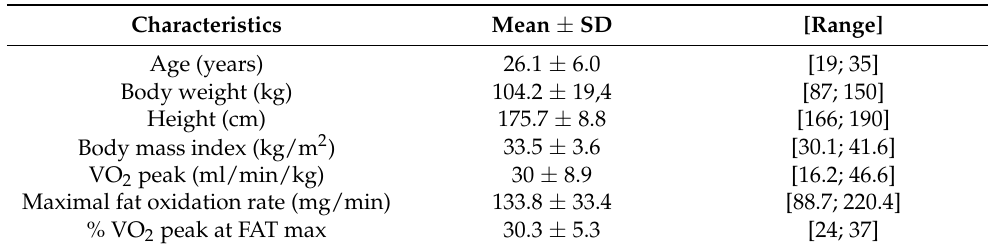
Table 1. Anthropometric data and physiological values measured during the exhaustive incremental exercise ( n =